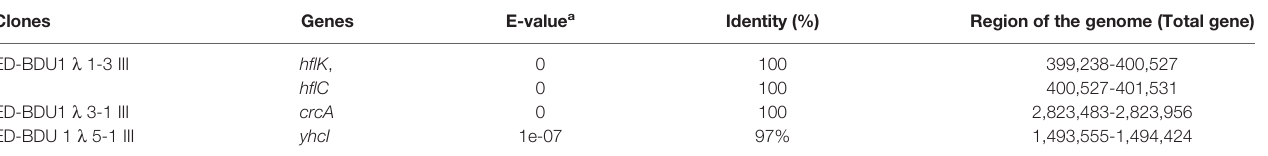
TABLE 3 | Genetic sequencing analysis by comparing the positive clones of E. tarda with the Gen Bank. Clones Genes E-value a Identity (%) Region of the genome (Total